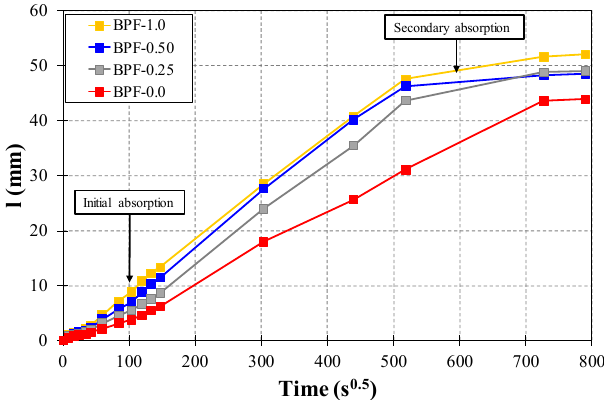
Figure 8. Representative curves of the capillary water absorption rate for each earthen mix.